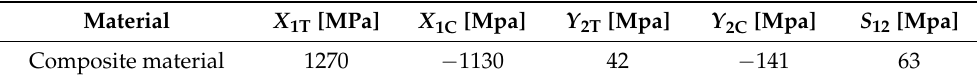
Figure 3. Laminate reference system. Table 7. Laminate mechanical properties.